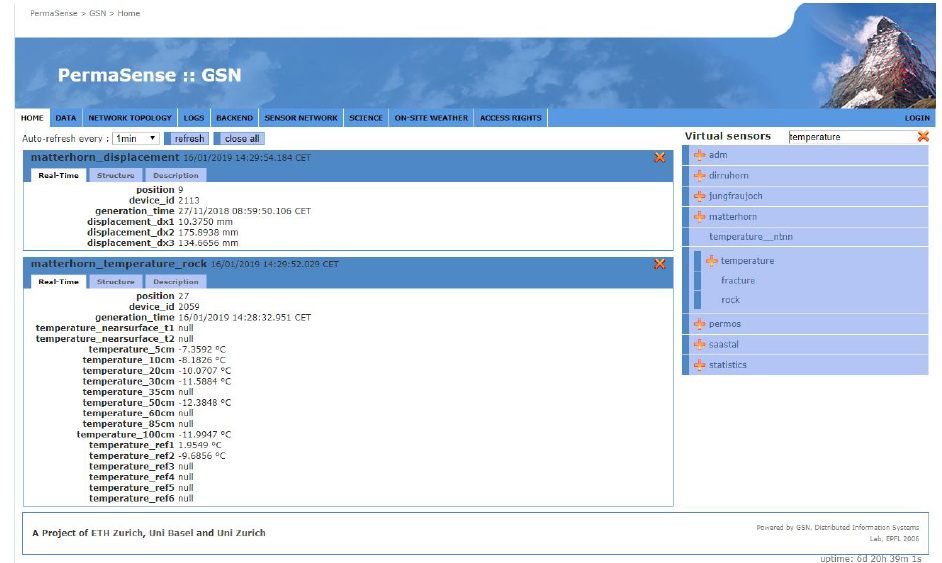
Figure B1. The online data management web frontend at http://data.permasense.ch allows access to all data in real time. Data are accessed by data type in entities called virtual sensors (right). Selected standard views, e.g., key graphs, can be accessed via the tabs at the top. Table B1. GSN multidata query interface